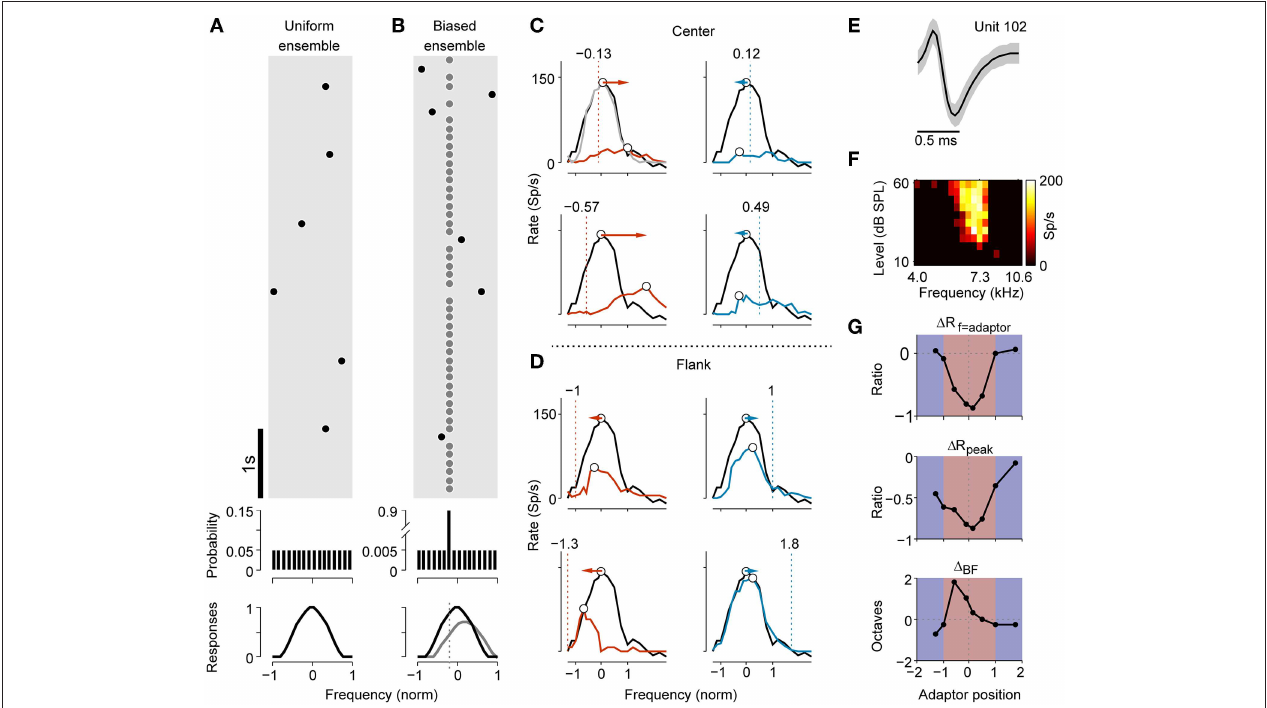
FIGURE 1 | Stimulus paradigm and adaptive change of frequency tuning in an example neuron. (A) A segment of the stimulus sequence in the uniform ensemble. Each dot symbolizes a tone. In the entire sequence, the probability distribution of presentation across frequencies was flat (middle panel). The non-adapted frequency-tuning curve to the sequence is illustrated in the bottom panel. (B) Stimulus sequence for a biased stimulus ensemble. The frequency probes (black dots) were selected in the same way as in the uniform ensemble, except that they were randomly interspersed in a repeating frequency adaptor (gray dots). The presentation probability of the adaptor was 90%. The bottom panel displays a hypothetic tuning curve for both the original (black) and adapted case (gray). (C) Comparison of non-adapted (black) and adapted tuning (colored) with adaptors close to the original BF (center adaptor) of an example neuron. The dashed lines and texts above annotate the normalized frequency of the adaptor (adaptor position). The frequency of the adaptor was below (red) or above (blue) the original BF. The light gray curve in the top left panel shows a second measurement of the non-adapted tuning after 30s of recovery. The BFs in both non-adapted and adapted tuning are marked as open circles. The colored arrows show the shift directions of the BFs, which were repulsive during adaptation. (D) Comparison of the non-adapted and adapted tuning when the adaptors were located on the far flank of the RF (flank adaptor). Using the same conventions as in (C) , the BFs shifted attractively toward the adaptors during adaptation. (E) The averaged spike waveform (mean ± SD) of the example neuron during a segment of recording. (F) FRA of this neuron (bandwidth of 30dB above threshold, BW 30 = 0.31 octave, Q 10 = 6.32 , CF = 7.26kHz). (G) The relative changes in the adaptor response (top, 1 R f = adaptor ), peak response over all frequencies (middle, 1 R peak ) and shift magnitude of the BF (bottom, 1 BF ) vary with the adaptor position. A positive 1 BF indicates a repulsive shift while a negative one represents an attractive